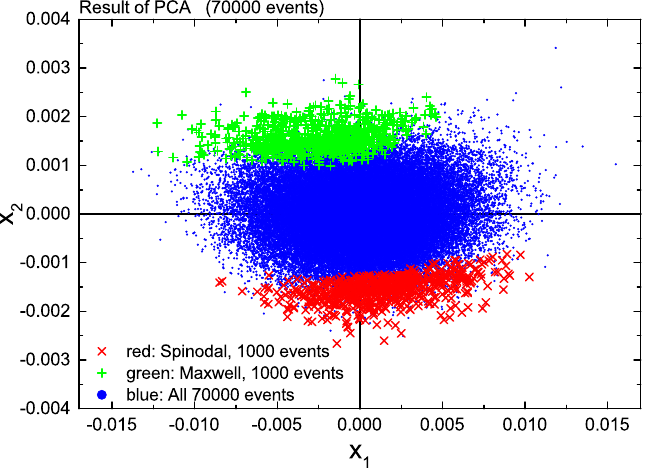
Figure 8 . Scatter plot of the (cid:12)rst two components of a PCA of the distributions of the momentum di(cid:11)erence for baryon pairs. The blue points correspond to all 70 000 events, Maxwell and spinodal. The red crosses correspond to those events that were identi(cid:12)ed correctly as being in the spinodal class from among those 1000 events that had the highest probability for being spinodal events, according to the neural network. Similarly, the green pluses show the correctly identi(cid:12)ed Maxwell events among the 1000 event having largest probability of belonging to that class. According to this